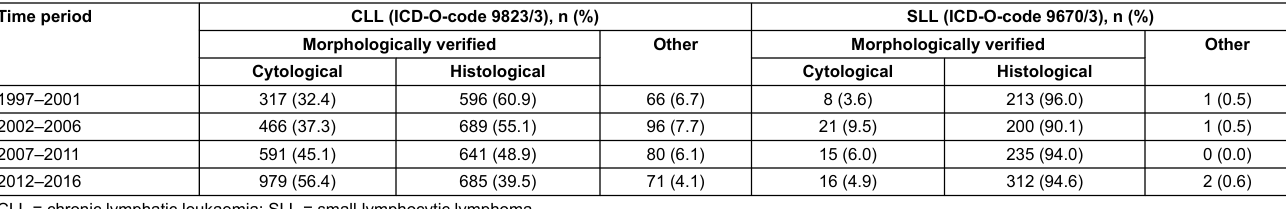
Table S2: Type of verification of the diagnosis by time period and diagnosis